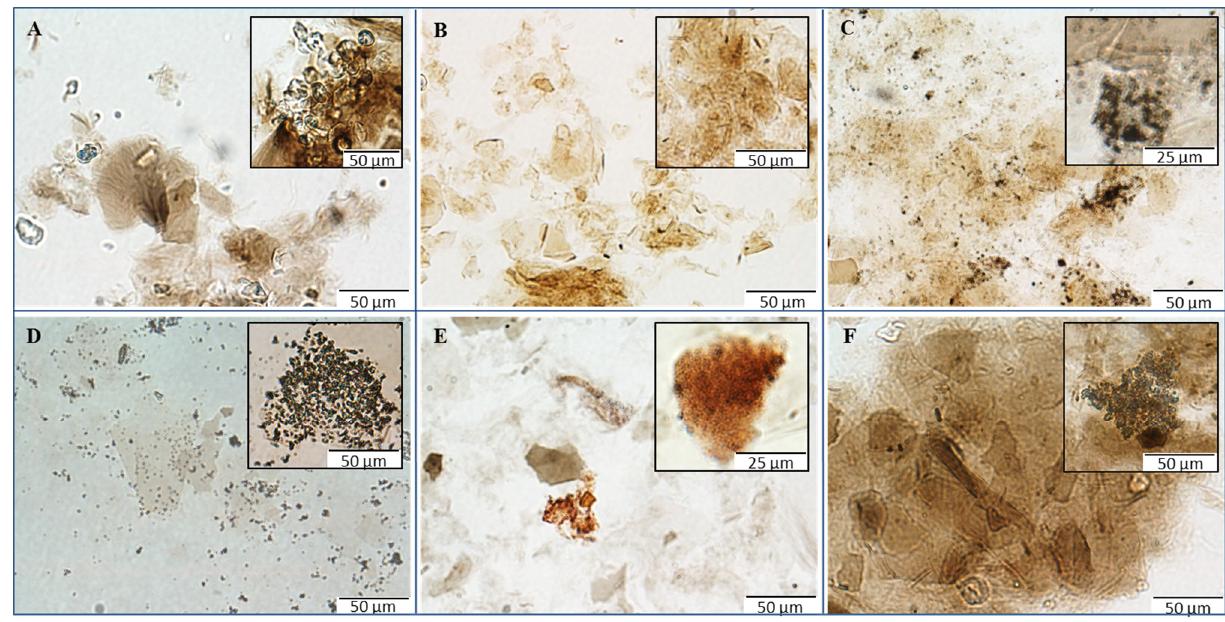
Figure 2. Micrographs of GO composites with metal- or metalloid-based nanoparticles using microscopy in ambient light: ( A ) composites of GO with copper-based nanoparticles; ( B ) composites of GO with manganese-based nanoparticles; ( C ) composites of GO with silver nanoparticles; ( D ) composites of GO with silver phosphate nanoparticles; ( E ) composites of GO with selenium nanoparticles; and ( F ) composites GO with zinc-based nanoparticles. The inverted system microscope Olympus IX 71 (Tokyo, Japan) with the total magnification 400× was used for the analysis. The images were captured by Olympus Camera DP73 and processed by Olympus Stream Basic 1.7 software with the images resolution 1600 × 1200 pixels and the length of scale bar 50 µm or 25 µm,